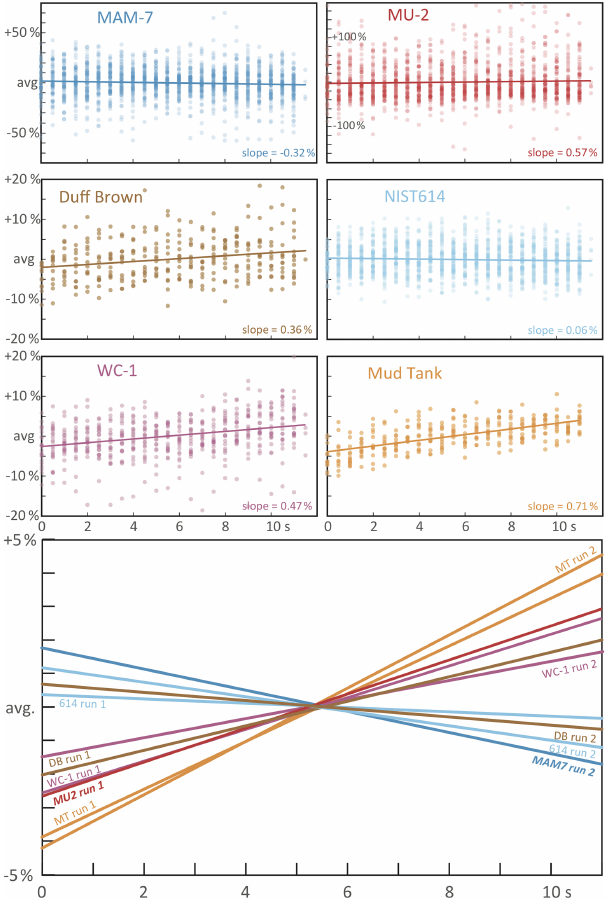
Figure 9. Average down-hole fractionation of RMs and selected unknowns. Raw 207 Pb-corrected values (corrected for baseline) are normalized to the average value, and a linear fit shows different frac- tionation trends between glass, zircon, calcite, and dolomite. The lower panel shows the difference in average down-hole fractiona- tion between unknown samples and reference materials in two dif- ferent analytical